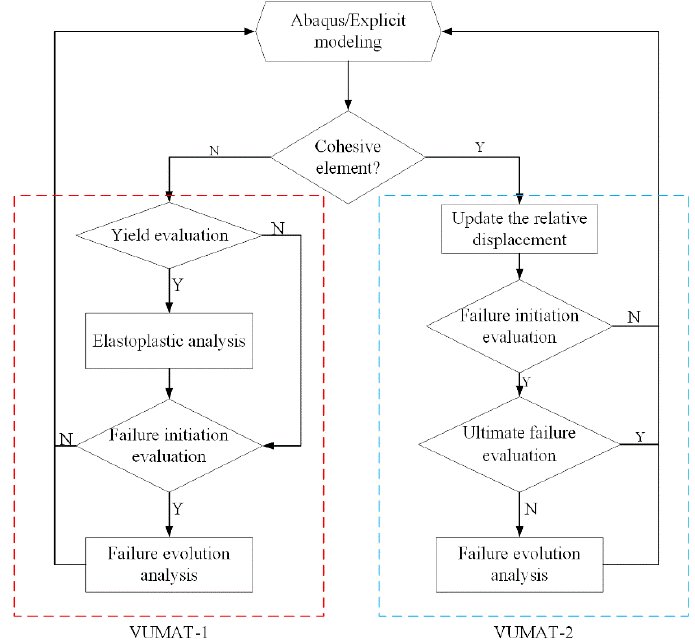
Figure 8. Flow chart of subroutine VUMAT.